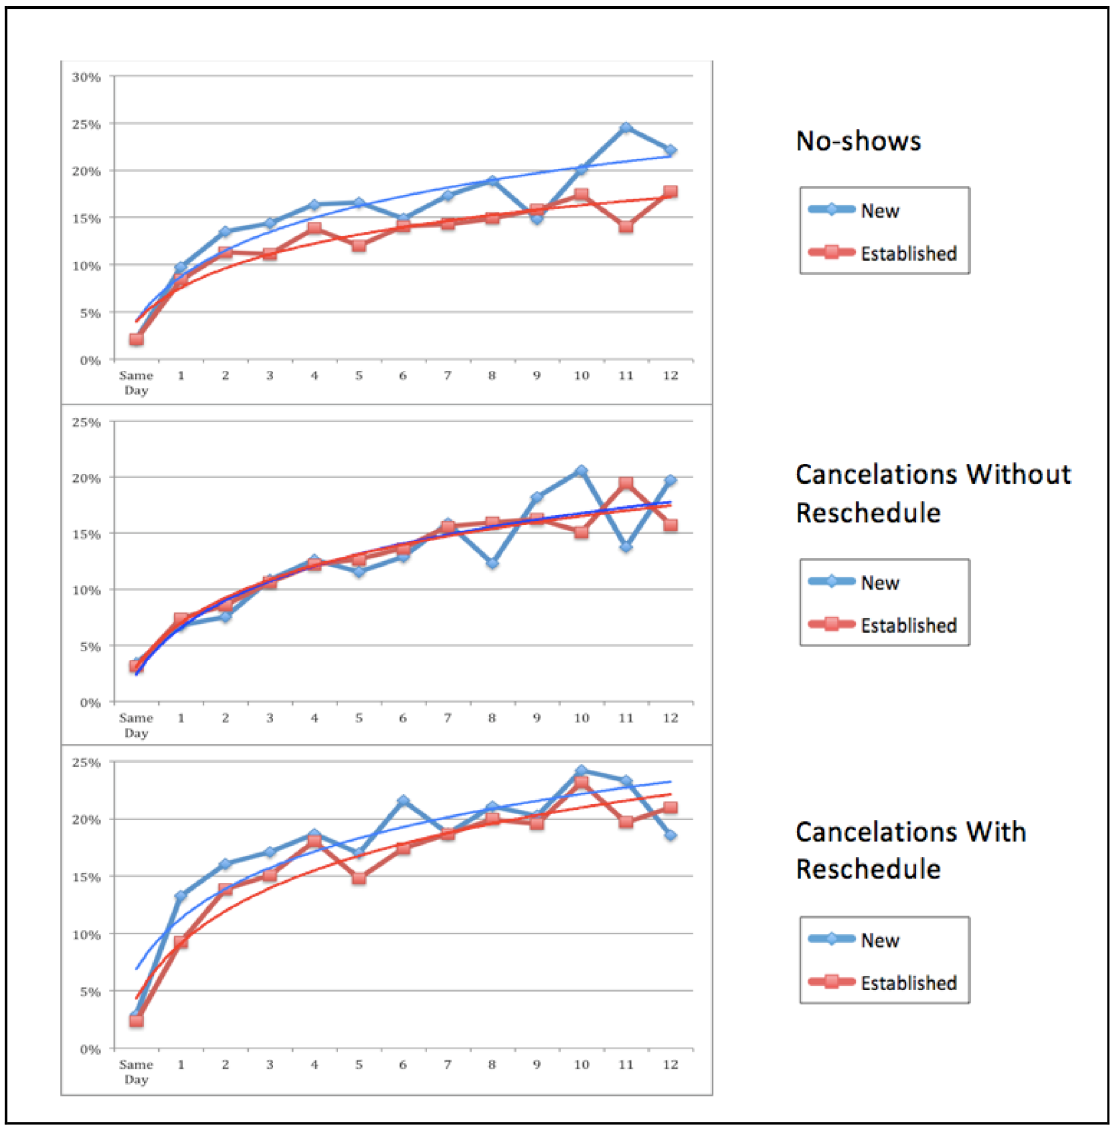
Figure 1. Plot of patient no-show, cancelation without reschedule, and cancelation with reschedule rates by waiting time (in weeks). Source: prepared by the authors based on hospital